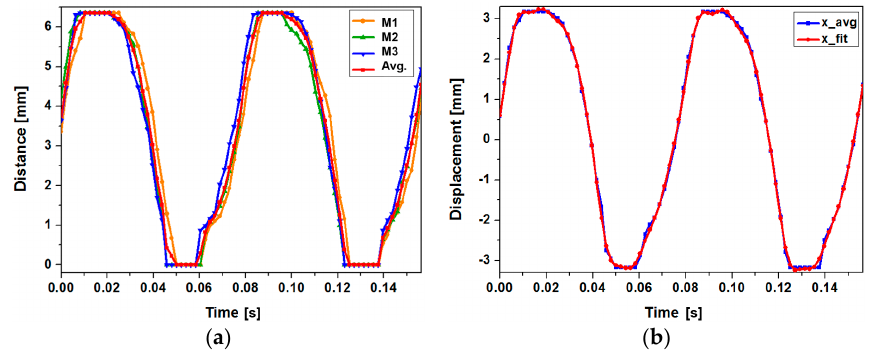
Figure 8. Motion of the magnet array in the harvester under the 3 g acceleration in 13 Hz: ( a ) experimentally determined position of the magnet array (M1–M3: individual measurements, Avg.: average of the measurements); ( b ) curve-fitting result of the magnet array position.